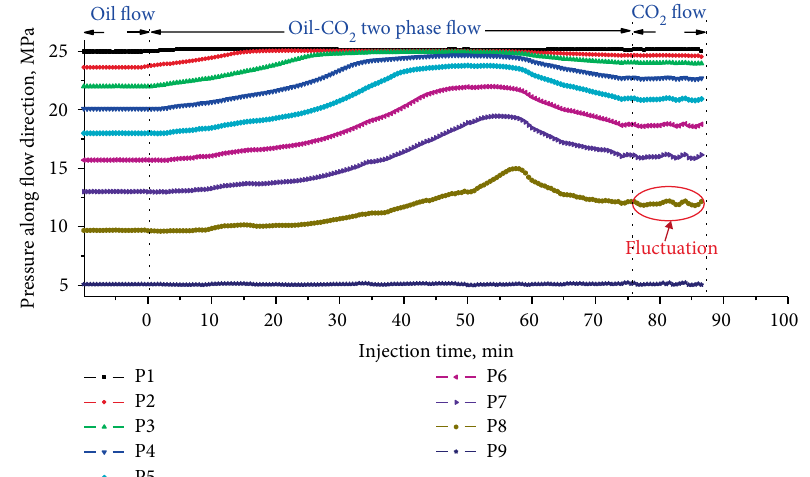
Figure 15: The CO